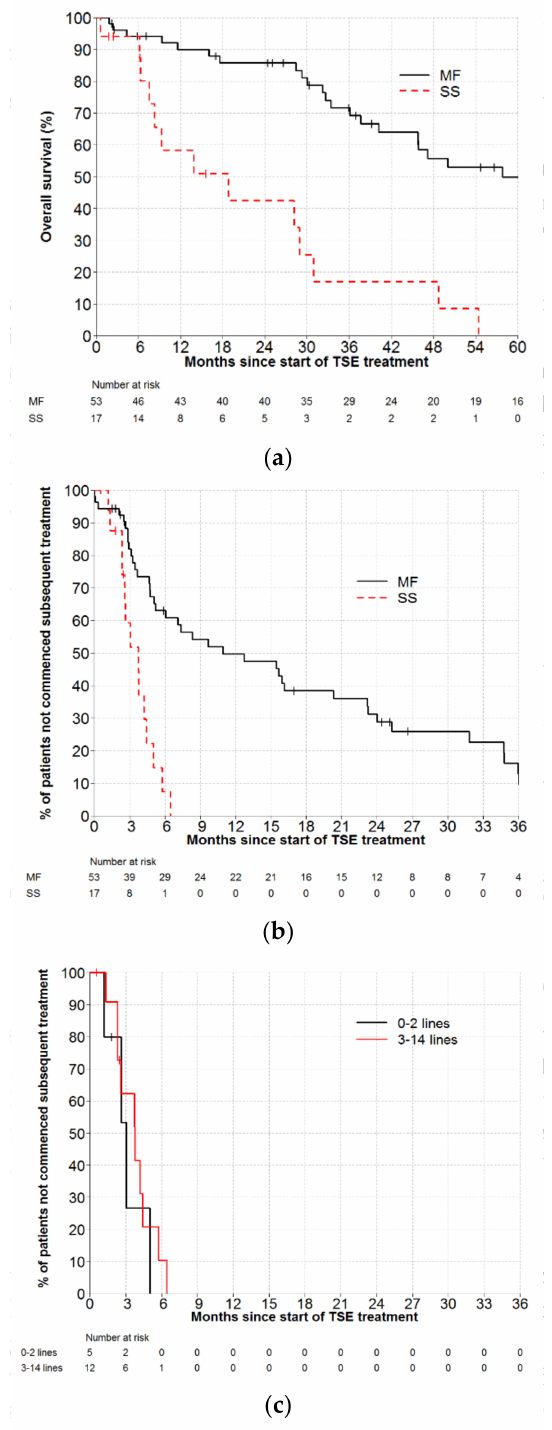
Figure 2. ( a ) Overall survival for patients with mycosis fungoides (MF) and Sezary syndrome (SS) treated with conventional-dose total skin electron therapy (TSE), HR = 5.0 (95% CI: 2.4–10.2, p < 0.001). ( b ) Time to next treatment for patients with mycosis fungoides (MF) and Sezary syndrome (SS) treated with conventional-dose total skin electron therapy (TSE), HR = 4.5 (95% CI: 2.2–9.2, p < 0.001). ( c ) Time to next treatment by number of previous lines of therapy in patients with Sezary syndrome treated with conventional-dose total skin electron therapy